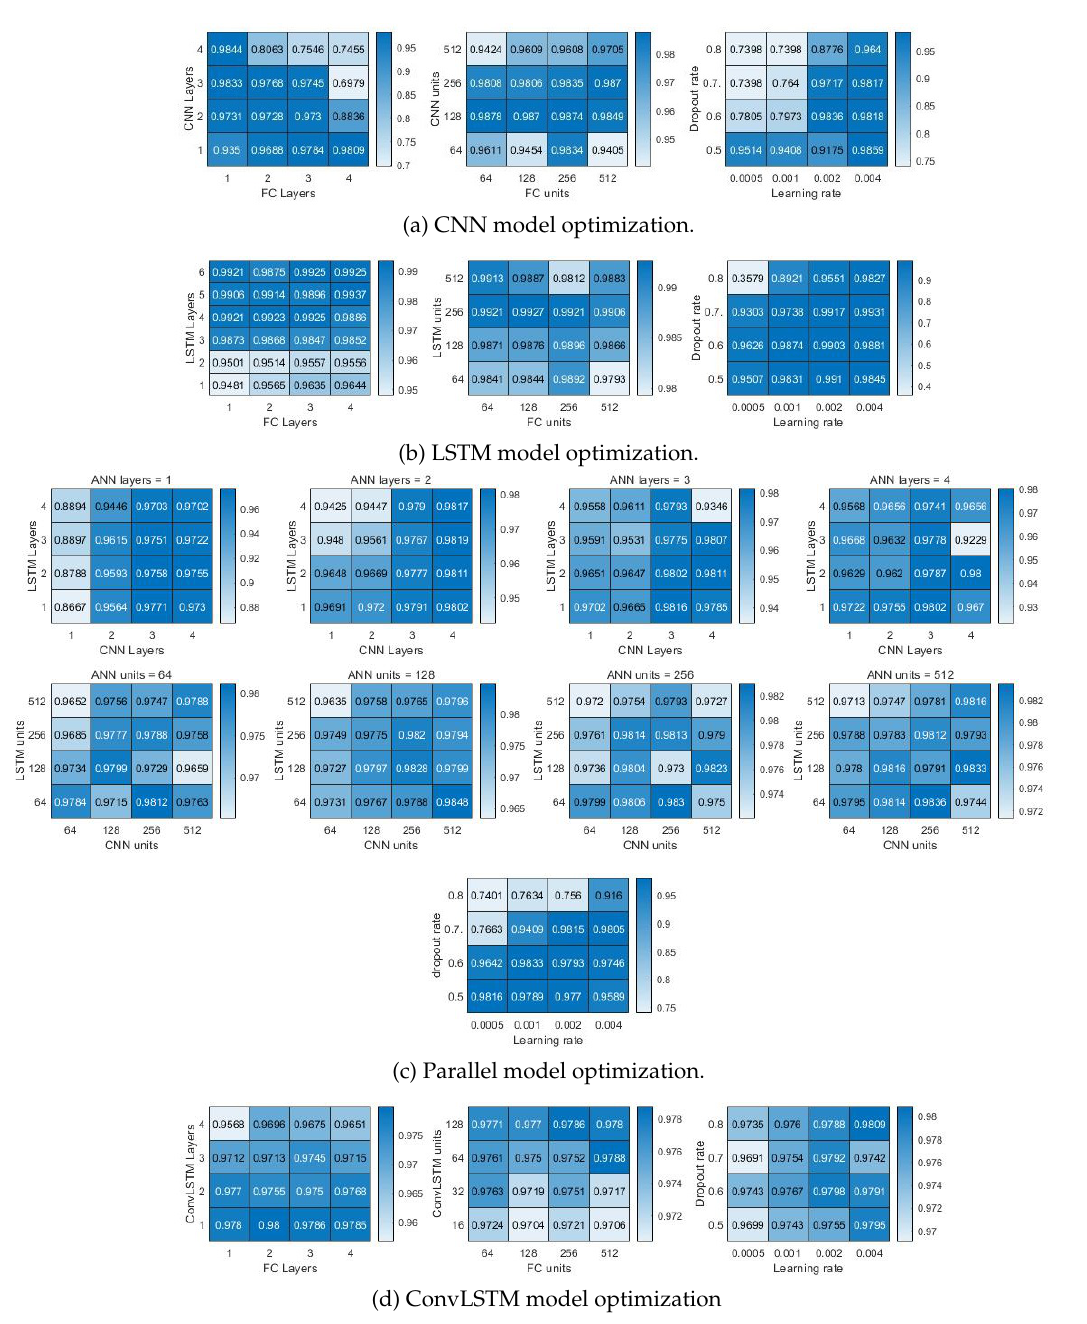
Figure 8. Neural networks models—grid search